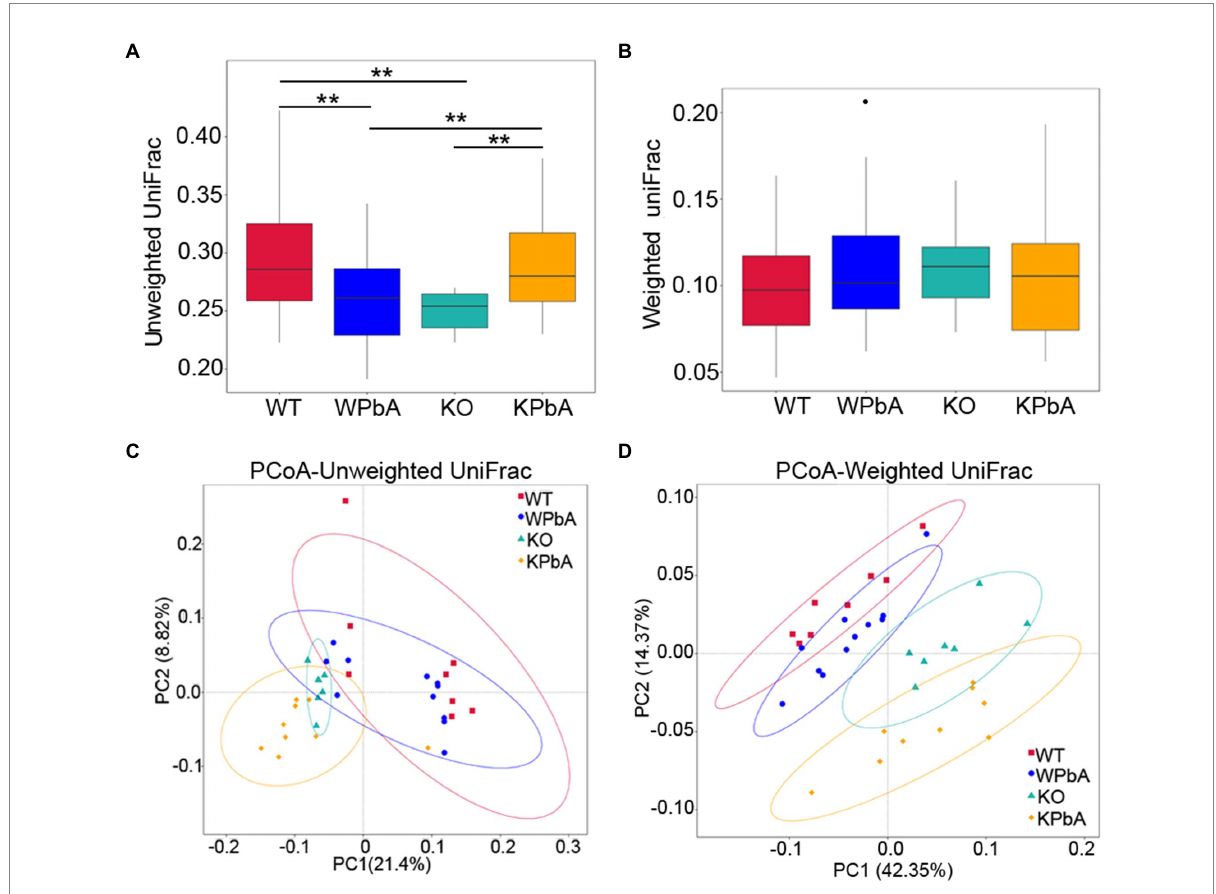
FIGURE 4 Comparative analysis of the microbial community composition among different groups by beta diversity. (A) Unweighted UniFrac, (B) weighted UniFrac, (C) principal coordinates analysis (PCoA) based on unweighted, and (D) weighted UniFrac distance matrixes for intestinal contents from four groups involved. Significant differences are indicated via ** p < 0.01.